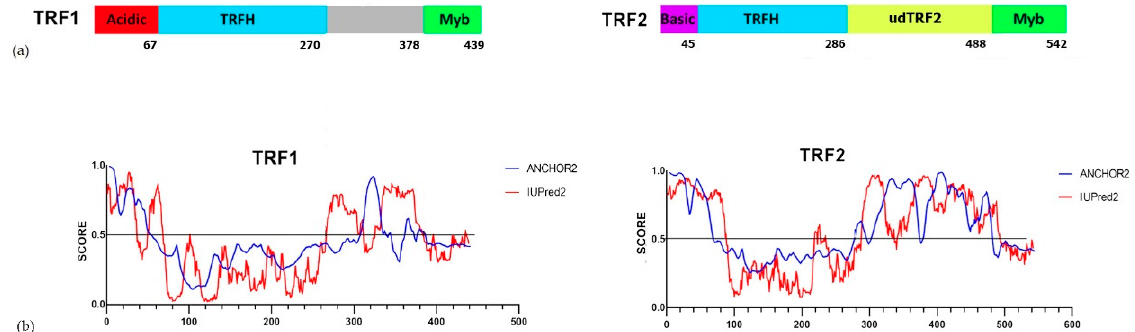
Figure 1. ( a ) Comparison of domain structures of TRF1 and TRF2. Basic, basic domain; Acidic, acidic domain; TRFH, TRF homology domain; Myb, DNA-binding Myb-domain. Numerals indicate the number of amino acid residues. ( b ) Prediction of the secondary structure dynamics of TRF1 and TRF2. IUPred2 (red) and ANCHOR2 (blue) scores are shown. The X-axis represents the amino acid number indicating its position in the sequence; the Y-axis represents the IUPred2 (red) scores that characterize the disordered tendency at each indicated position along the sequence; residues with a predicted score above 0.5 are considered disordered; ANCHOR2 (blue) scores characterize the probability of each residue being part of a binding region. The udTRF2 region of TRF2 is the intrinsically disordered region (IDR) that separates ordered TRFH and Myb domains. TRF1 also has an IDR between TRFH and Myb domains, but it is about half of udTRF2 and contains fewer residues, that could potentially be part of a binding region.